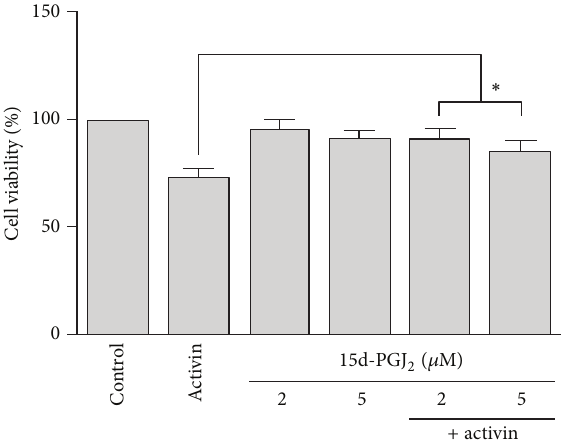
Figure 1: Effects of activin and 15-deoxy- Δ 12,14 -prostaglandin J 2 (15d-PGJ 2 ) on HepG2 cell proliferation. HepG2 cells were exposed to activin A (25ng/mL) or 15d-PGJ 2 (2 or 5 𝜇 M) alone or in combination for 72h. Cell viability was determined by using an MTT assay. The data are shown as the mean ± SEM of triplicate samples. ∗ 𝑃 < 0.05 , comparison of stimulation by 15d-PGJ 2 and activin A versus activin A stimulation